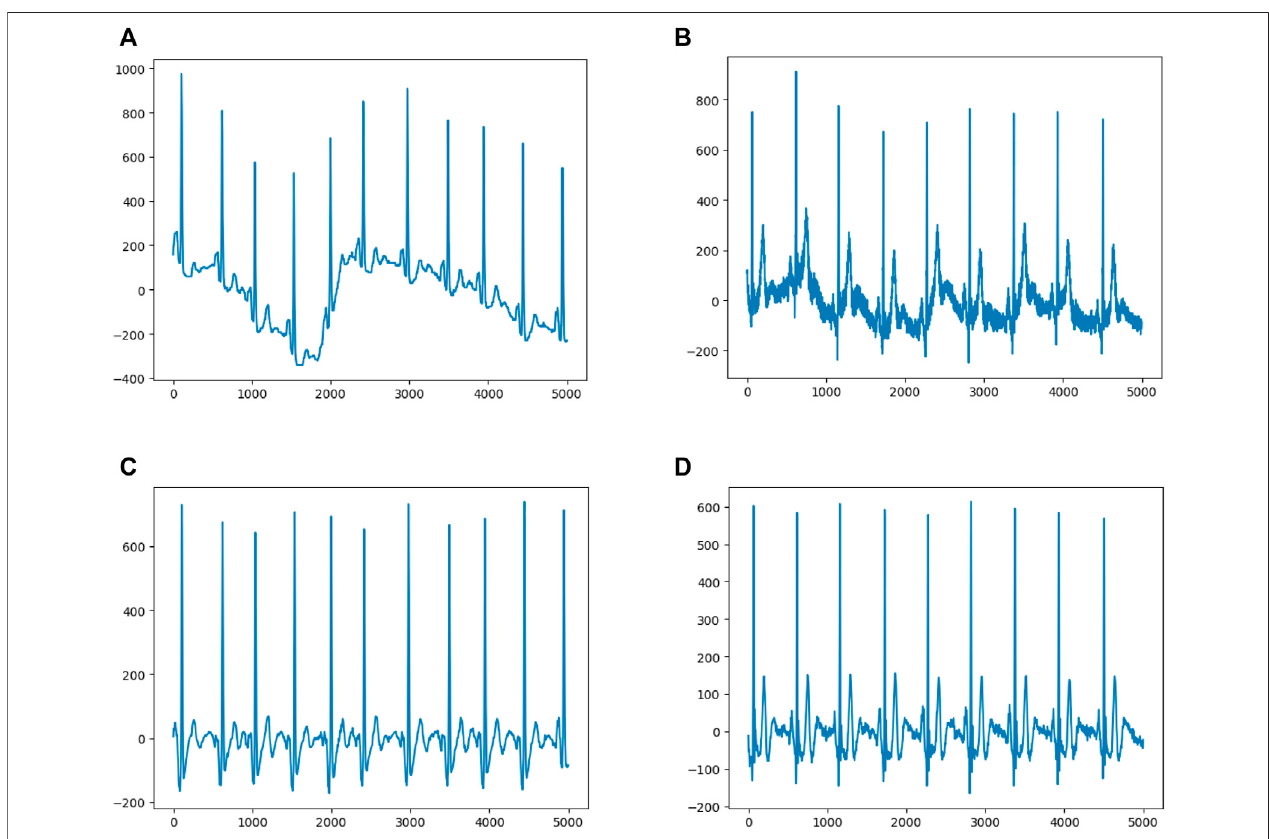
FIGURE 2 | Data Preprocessing (A) and (B) show representative ECGs with baseline drift and noise, respectively (C) and (D) show representative ECGs after preprocessing.